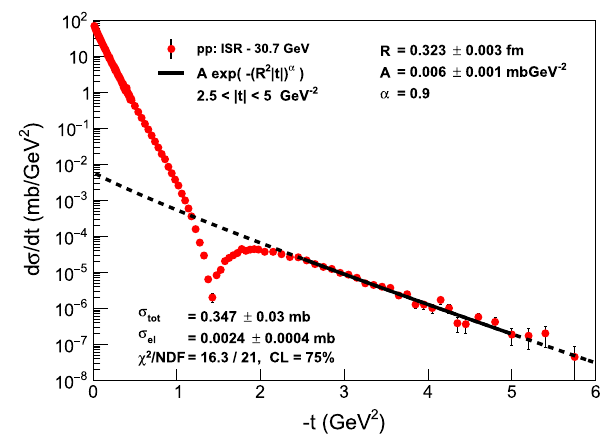
Fig. 29 Zeroth-order Lévy fits to the tail of the differential cross- section data on pp elastic scattering at fixed α = 0 . 9, A and R as free fit parameters